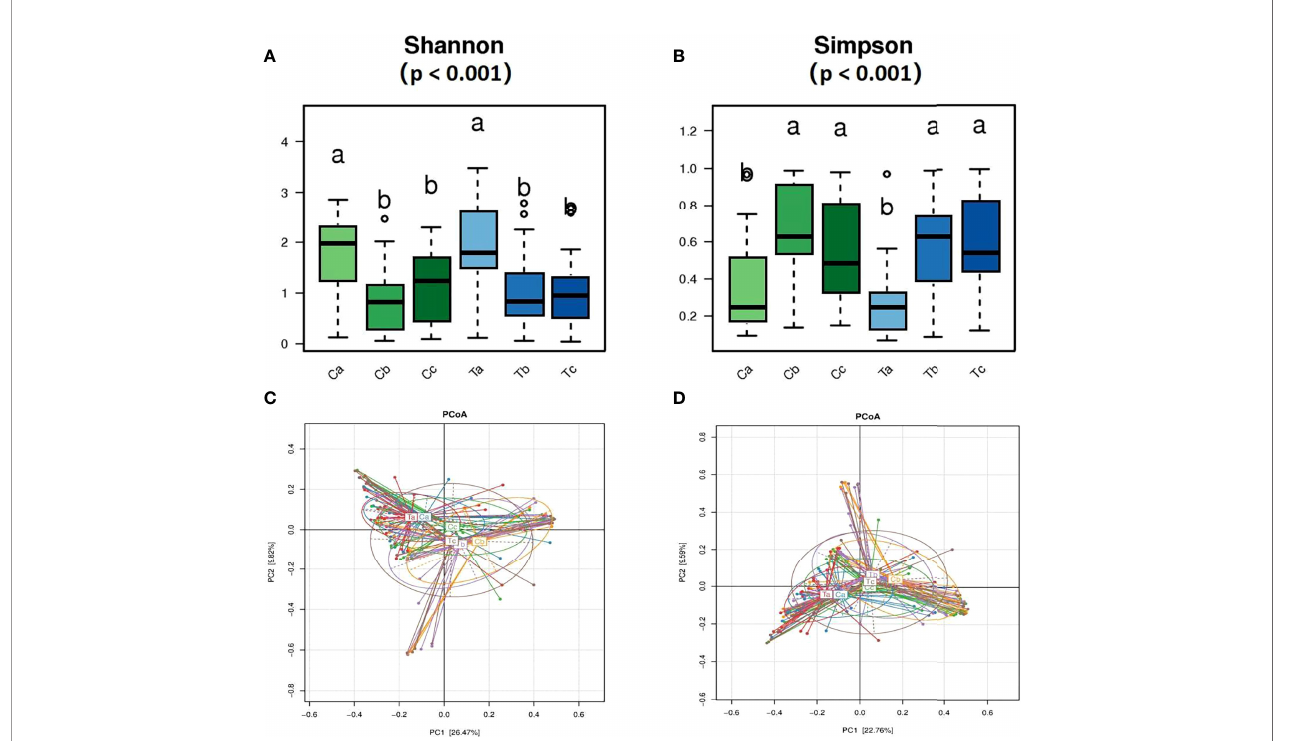
FIGURE 3 | Comparisons of the vagina microbiota a diversity (A, B) and relative (C) and absolute (D) abundances in the principal coordinate analysis (PCoA) of bacterial b diversity. (A, B) rank all the mean values from highest to lowest using signi fi cant difference letter notation. The largest mean is marked with the letter a and compared with other means, where the difference is not signi fi cant, the letter a is marked until an average with a signi fi cant difference is marked with the letter